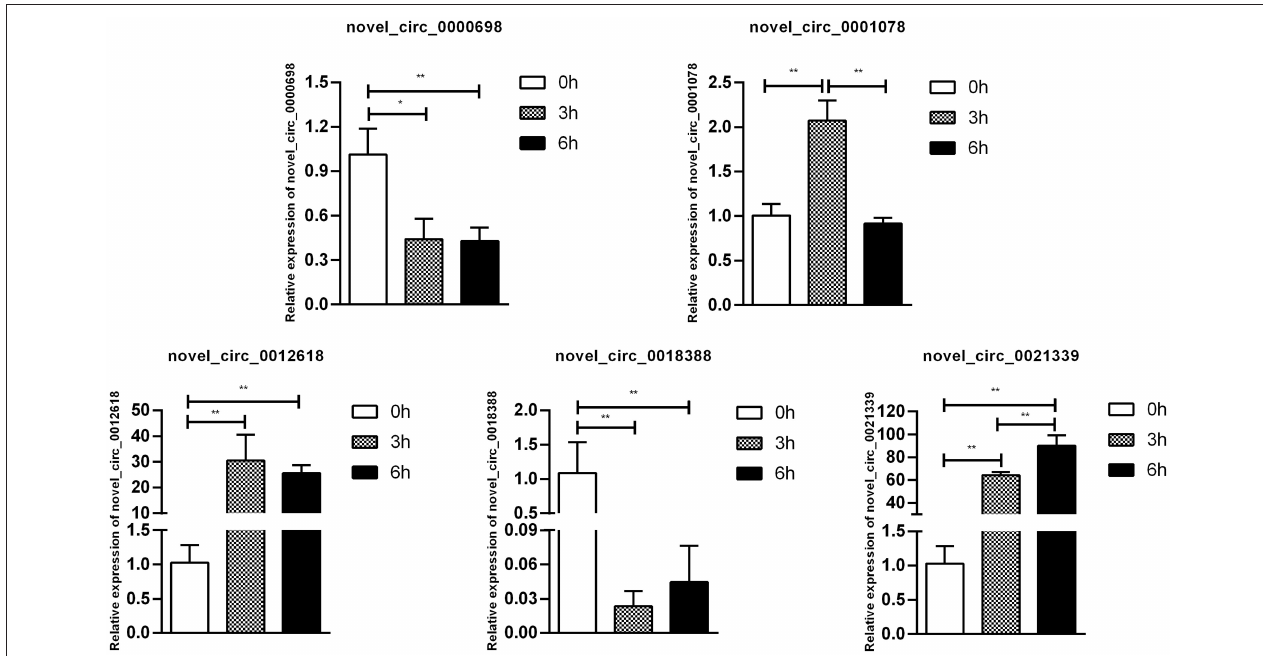
FIGURE 9 | Validation of circRNA differential expression results during SE infection in duck granulosa cells at 0, 3, and 6 hpi. qRT-PCR validation of novel_circ_0018388, novel_circ_0021339, novel_circ_0012618, novel_circ_0001078, and novel_circ_0000698. circRNA expression levels in cell samples between 0, 3, and 6 hpi. The circRNA expression levels at 3 and 6 hpi were normalized to the value at 0 hpi. Error bars indicate the mean ± SD of triplicate experiments. β -actin was used as as reference gene. * P < 0.05; ** P < 0.01.